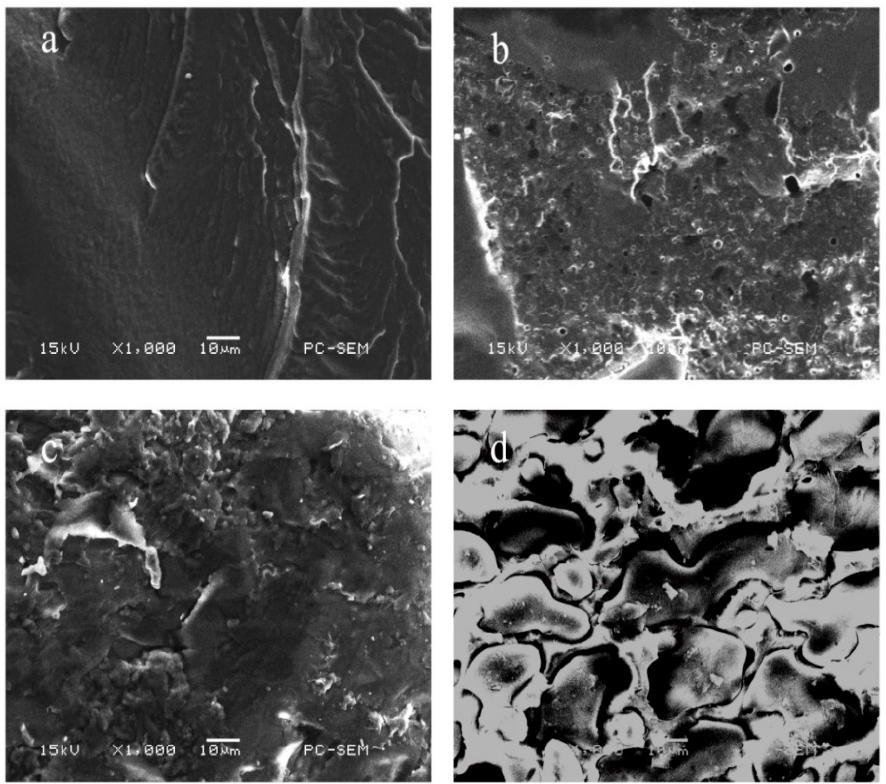
Figure 7. SEM spectra of TPS/PLA blend. ( a ) Pure PLA; ( b ) 20% TPS/PLA; ( c ) 40% TPS/PLA; ( d ) 60 TPS/PLA.